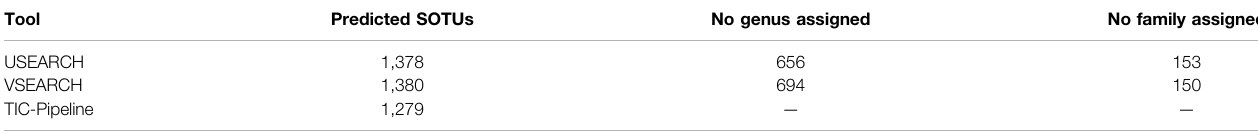
TABLE 3 | Comparison of TIC with naïve clustering approaches on microbial amplicon data from mice.